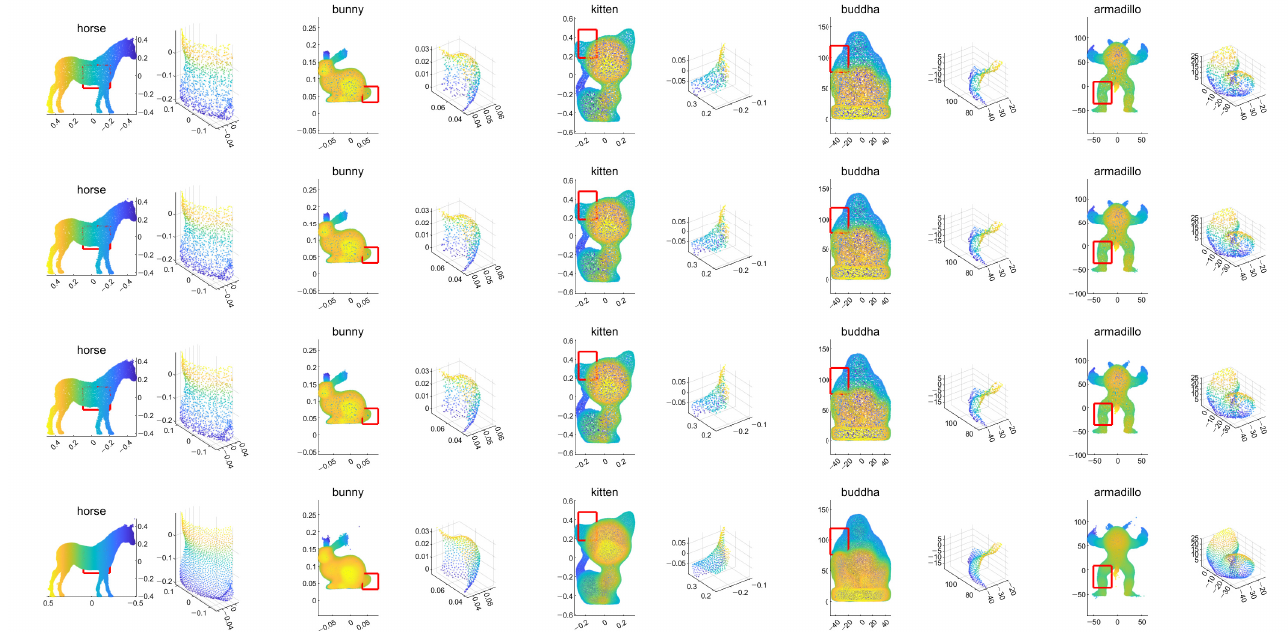
Figure 4. Example results for the tangential noise cases. The first row is the input point cloud, the second row is the resampling result of the LOP algorithm, the third row is that of the WLOP, and the final row is that of the proposed algorithm. The odd columns are the resampled point cloud (from left to right, Horse, Bunny, Kitten, Buddha, and Armadillo), and the even columns are the corresponding enlarged